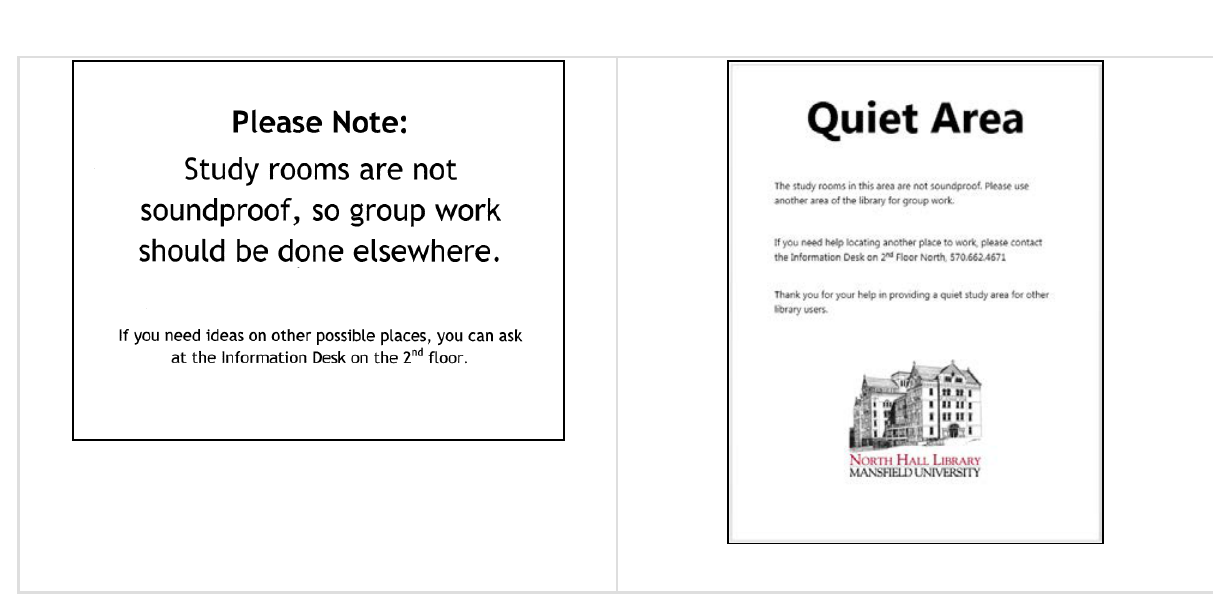
The boldest and largest words on the old sign (left) are “Please Note.” It is difficult to determine what the purpose of the sign is without reading its entire text. In the new sign (right) the bold, large font at the top quickly and directly expresses the message.